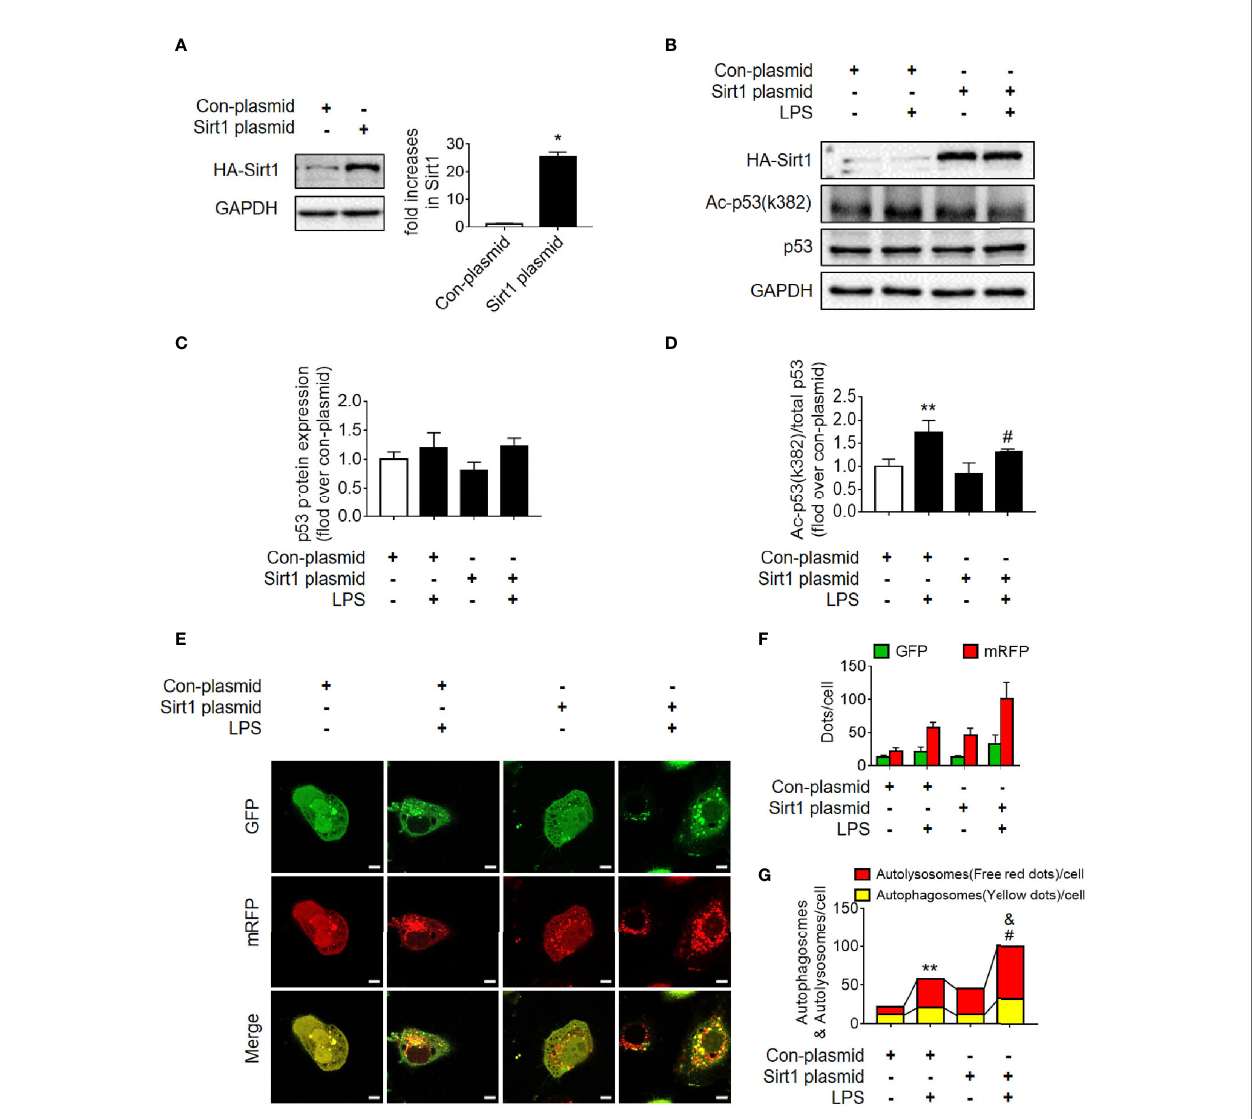
FIGURE 7 | Determination of the effects of Sirt1 plasmid transfection. (A) Con fi rmation of plasmid-induced Sirt1 overexpression using western blot. Con-plasmid, control plasmid. (B) Representative western blot of HA-Sirt1, acetylated-p53 (Ac-p53), and p53 in LPS-treated HK-2 cells. (C, D) Densitometric analyses of p53 protein expression and acetylated-p53 (Ac-p53). n = 3-4. (E) Effects of Sirt1 overexpression on autophagic fl ux based on the cellular immunoassay following LPS stimulation at different groups (magni fi cation ×630 and scale bar = 10 µm). (F) Effects of Sirt1 overexpression on GFP and mRFP counts per cell. (G) Effects of Sirt1 overexpression on autophagosomes and autolysosomes per cell. * p < 0.05, ** p < 0.01 vs. con-plasmid group; # p < 0.05 vs. con-plasmid + LPS group; & p < 0.05 vs. the Sirt1 plasmid group. The results are representative of at least three independent experiments. LPS, lipopolysaccharide; GFP, green fl uorescent protein; mRFP, monomeric red fl uorescent